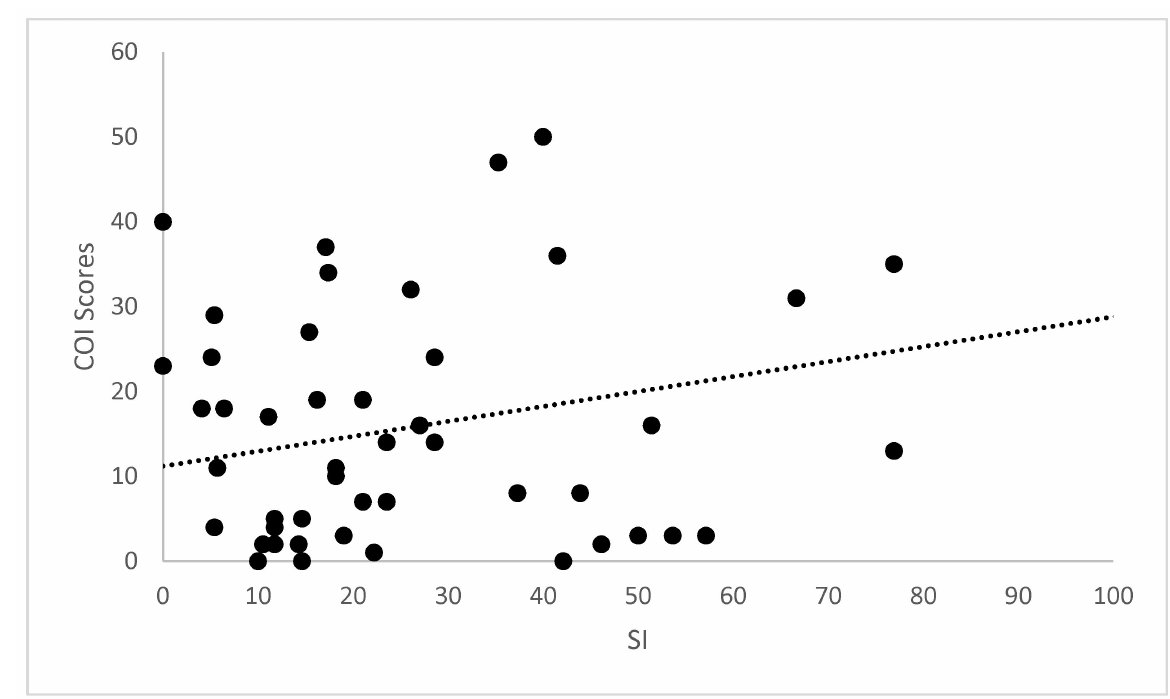
Figure 1. Scatterplot of COI (Canine Orthopaedic Index) versus SI (symmetry index) in the cross-